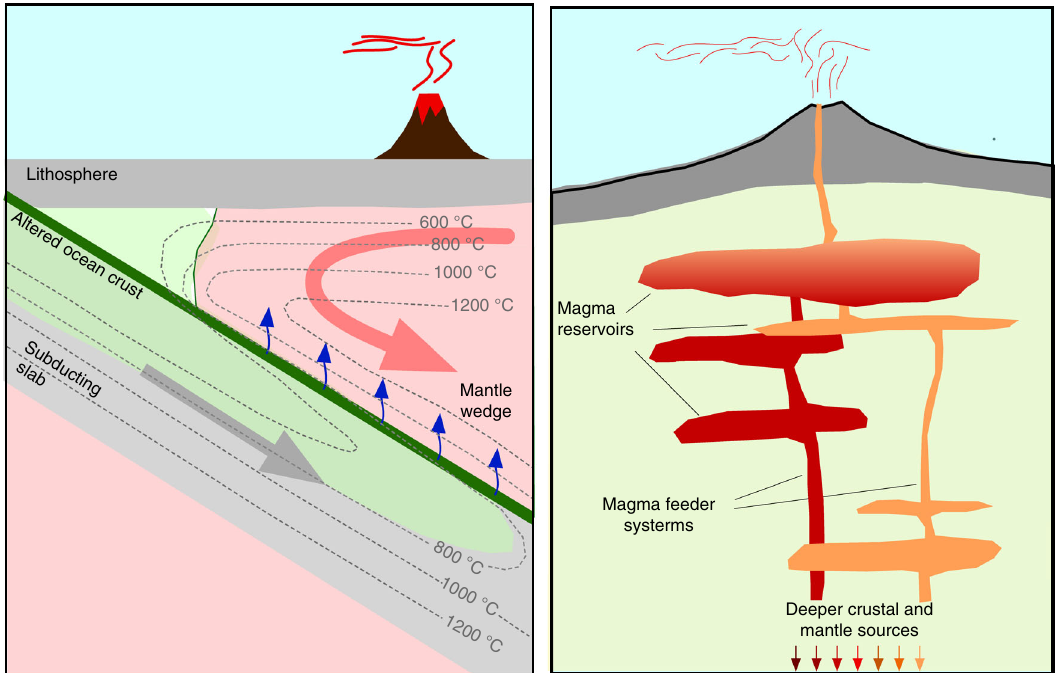
Fig. 3 Representative fi gures from different communities studying volcanoes. Left, archetypical mantle-focused subduction cartoon with an “ emoji volcano ” that only alludes to a shallower magmatic system. Right, archetypical upper crust-focused subduction volcano cartoon, with a “ disembodied volcano ” , disconnected from the deeper magma source